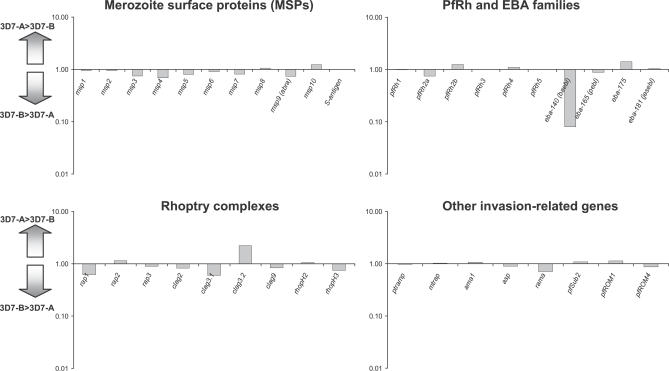
Microarray Comparison of Expression of Invasion-Related Genes between 3D7-A and 3D7-B SchizontsValues correspond to the ratio of expression in 3D7-A versus 3D7-B. Values for each parasite line are the average of two experiments.